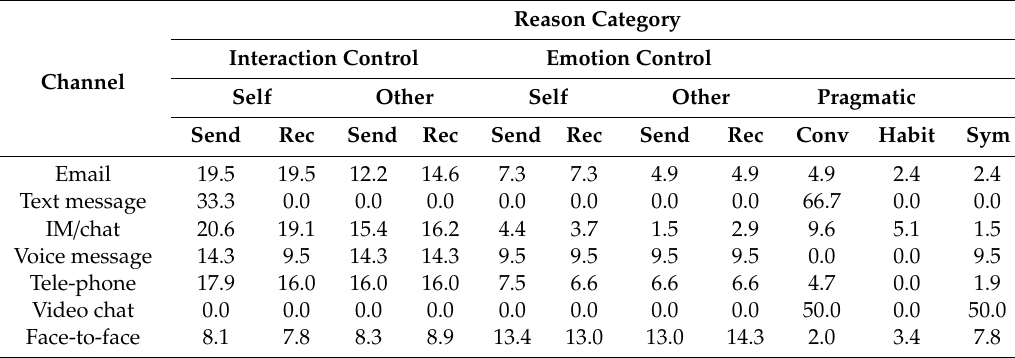
Table 3. Relative frequencies [% of row] of reason categories for each channel